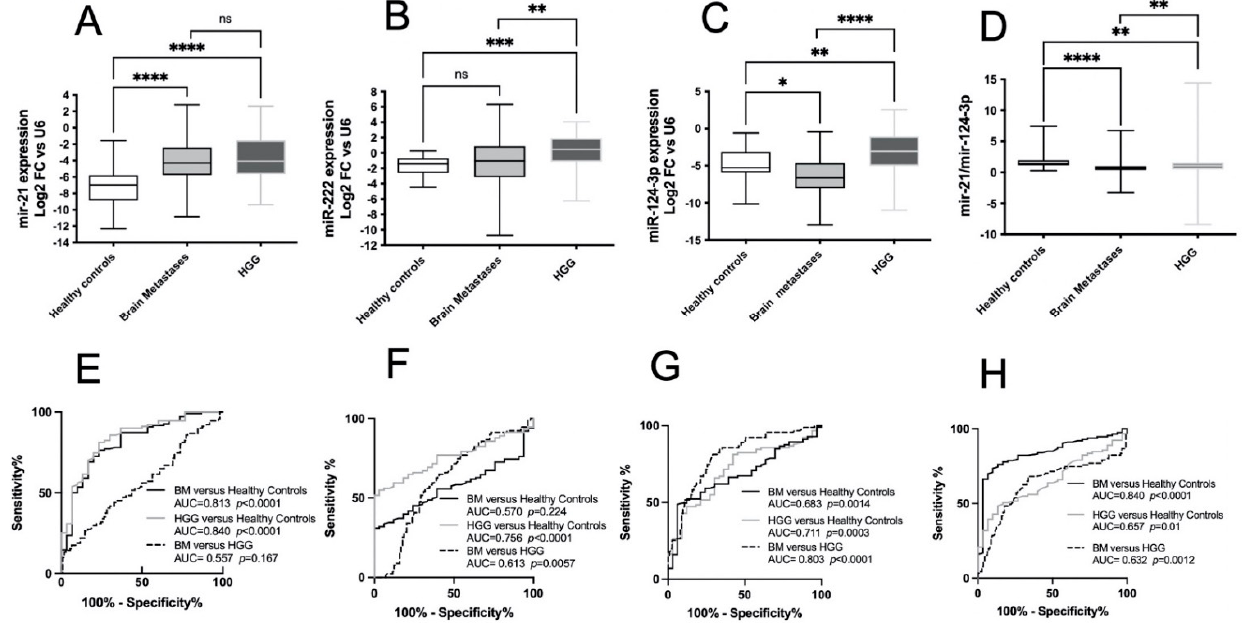
Figure 1. miRNA expression in serum exosomes of healthy controls and patients with BMs and HGGs . miR-21 ( A ), -222 ( B ) and -124-3p ( C ) expression in serum exosomes was measured with real-time qPCR with TaqMan probes and normalized to U6 snRNA. Data are expressed as Log2FC. Ratio miR- 21/miR-124-3p ( D ). Lines in the boxes are median, and 25% and 75% percentile values; bars indicate minimum and maximum values. Comparisons between healthy controls and patients with BMs and HGGs were analyzed with non-parametric Kruskal–Wallis tests. Differences were considered statistically significant with p < 0.05 (*), p < 0.01 (**), p < 0.001 (***) and p < 0.0001 (****). Median values and CIs are indicated in Table 2. ( E – H ) ROC curves showing sensitivity and specificity for miR-21 ( E ), -222 ( F ), -124-3p ( G ) expression and ratio miR-21/miT-124-3p ( H ). AUC is area under the curve. ns means “not significant”. Table 2. Median values and 95% CIs of miR-21, miR-222, miR-124-3p and ratio miR-21/miR-124-3p in healthy controls and patients with brain metastases (BMs) and high-grade gliomas (HGGs).